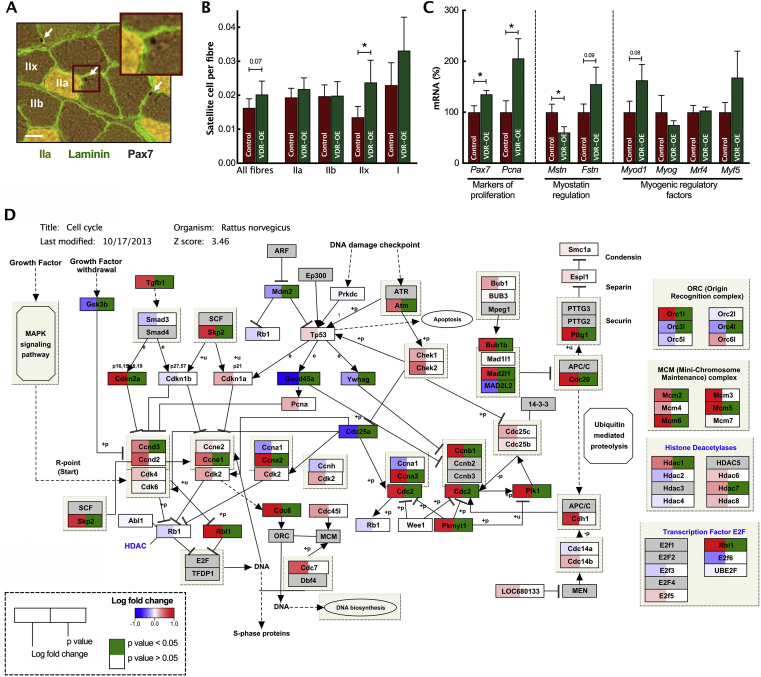
In vivo VDR-OE results in increased satellite cell content. (A) Representative image of muscle fibres stained for Pax7 (Black), Laminin (Green) and IIa fibres (Yellow). Arrows signify Pax7+ nuclei of satellite cells and subsequent quantification (B). (C) qRT-PCR measurement for markers of proliferation and MRFs (n = 7). (D) RNA-Seq pathway analysis of Rattus norvegicus cell cycle gene expression. Log fold changes are shown as a gradient from red (upregulated) to blue (downregulated). P-values <0.05 are displayed as green. Scale bars represent 200 μm. Data are mean ± SEM. ∗p < 0.05, ∗∗p < 0.01 between indicated groups. (For interpretation of the references to color in this figure legend, the reader is referred to the Web version of this article.)